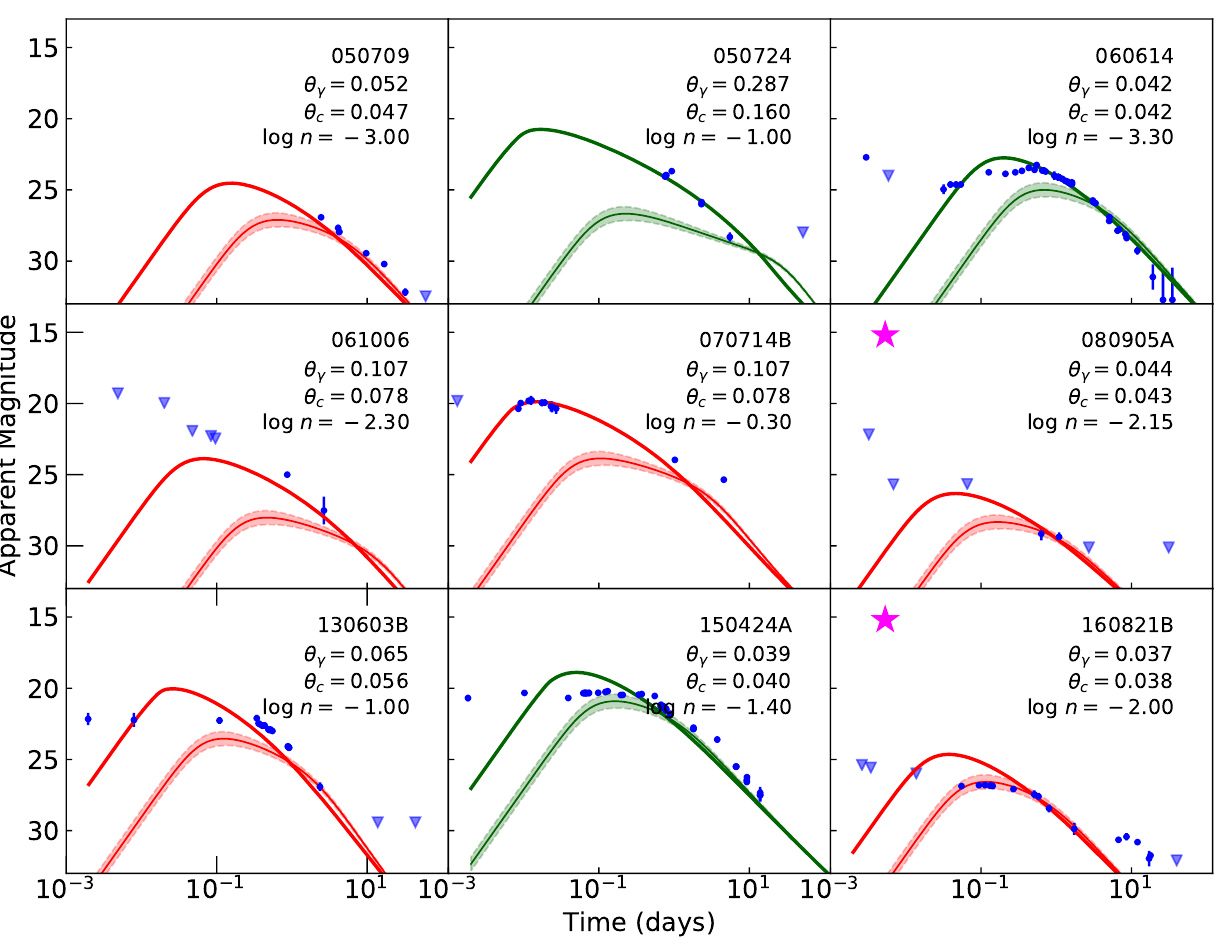
Figure 8. GRBs in our sample with candidate kilonova claims in the literature. Our afterglow model with a fixed energy is shown to be consistent with the observed lightcurves. In each case we modify the jet structure profile with the candidate kilonova’s reported eject mass, and vary the ambient medium to give a satisfactory alignment between the 0 ≤ ι ≤ θ γ for the lightcurves, thick and thin red/green lines, respectively. Lightcurves in green have ε B = 0.1 instead of the fiducial, ε B = 0.01. Each panel shows θ γ , θ c , and the log n , where n is given in cm − 3 . Panels marked with a pink star (GRBs 080905A, and 160821B) have a reduced energy (by a factor 0.1) to better describe the observed afterglows. Note—afterglow parameters are not fits to the data, and the afterglow models do not include the kilonova, reverse shock, or energy injection contribution. Figure 2, where ι ∼ 4 − 5 θ c , and fits for the rotationally averaged simulation